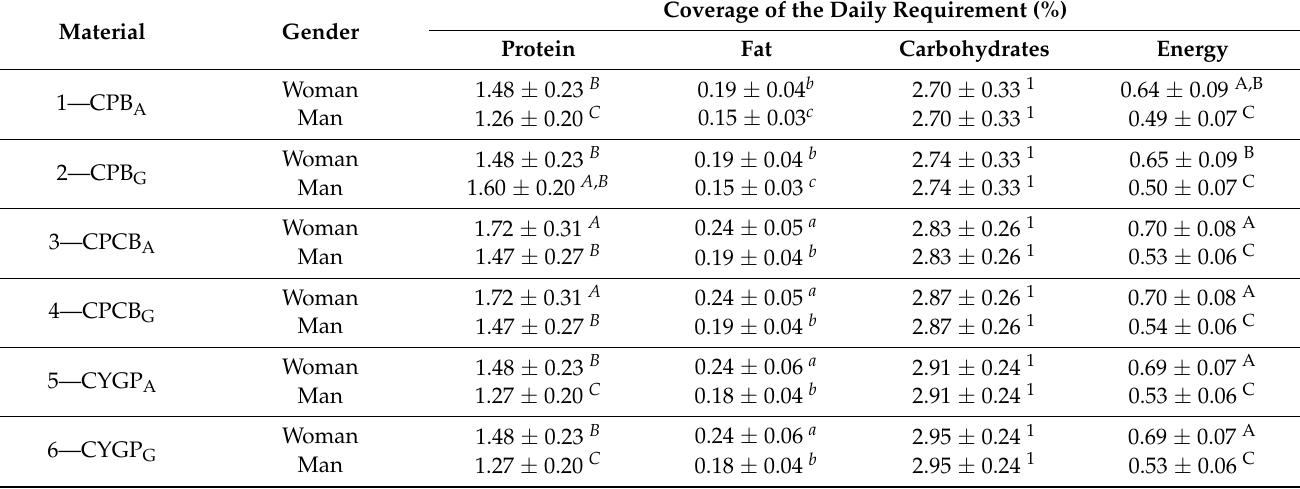
Table 4. Average coverage of the daily requirement (CDR) for protein, fat, carbohydrates, and energy in the human diet by freeze-dried products based on vegetables produced with hydrocolloids (10